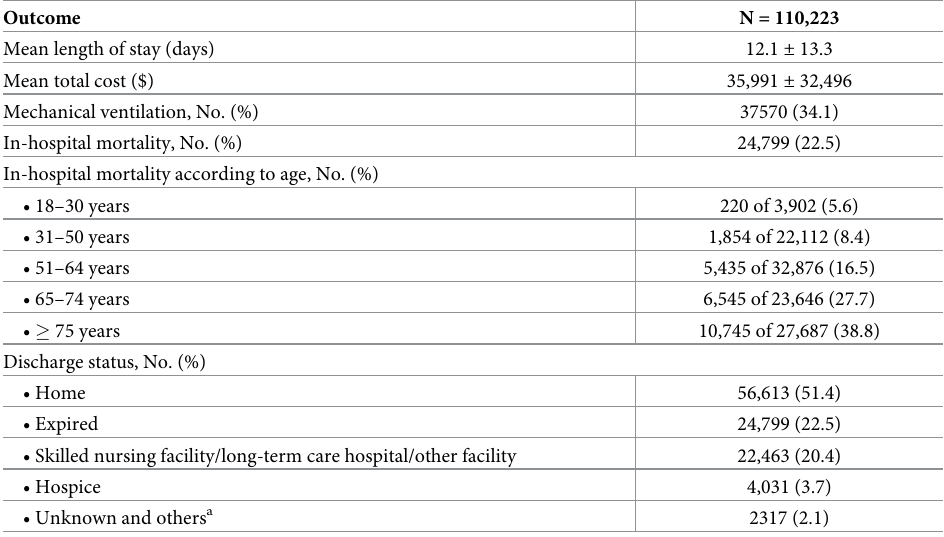
Table 2. Outcomes of adults with COVID-19 and acute respiratory distress syndrome or acute respiratory failure. Outcome Mean length of stay